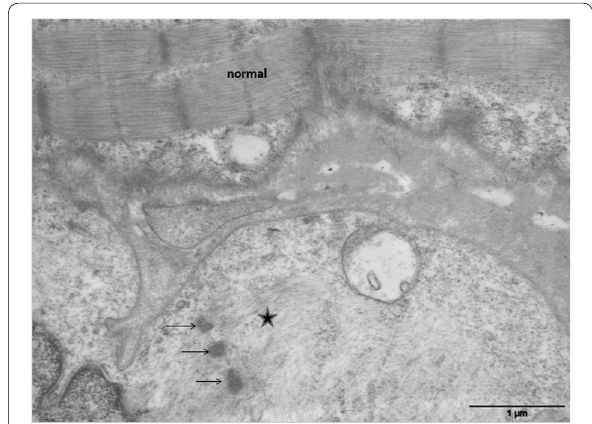
Fig. 5 Electronic Microscopy: muscle fiber with visualization of Z streak (arrows) and myofilament (star)